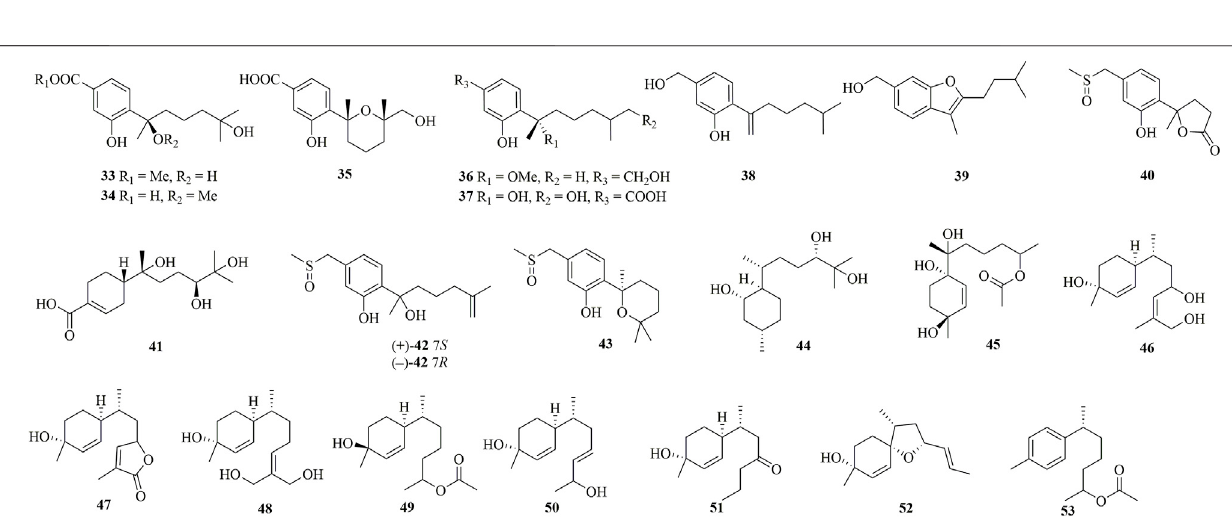
FIGURE 3 | Bisabolanes characterized from marine-derived fungi (Continued) ( 33 – 53 ).